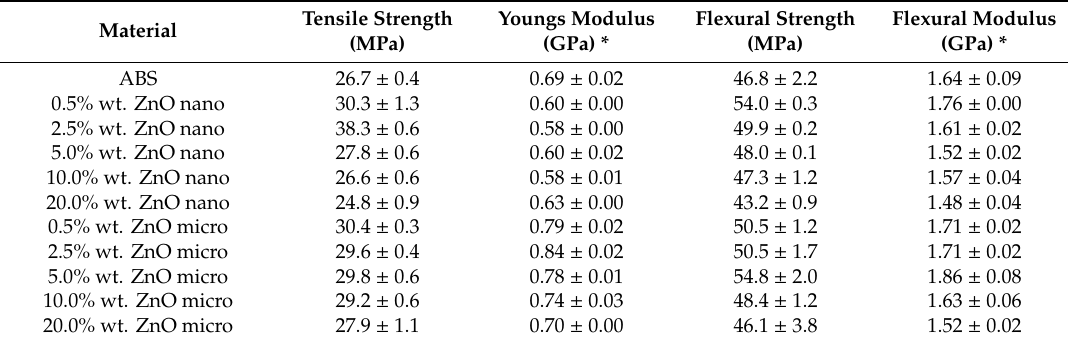
Table 2. Tensile and flexural properties and deviations of each material